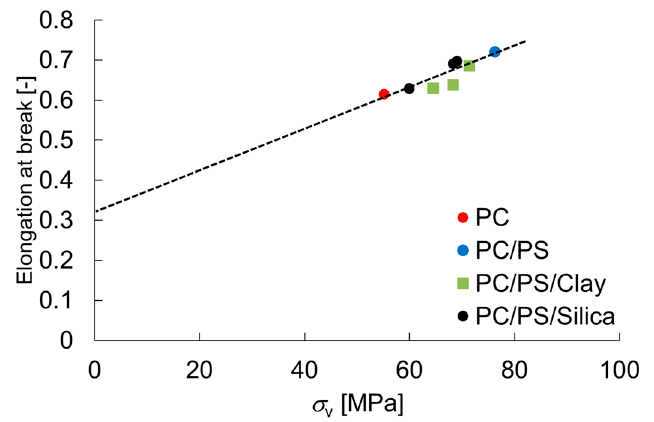
Figure 7. Relation between the elongation at break and stress of expansion.